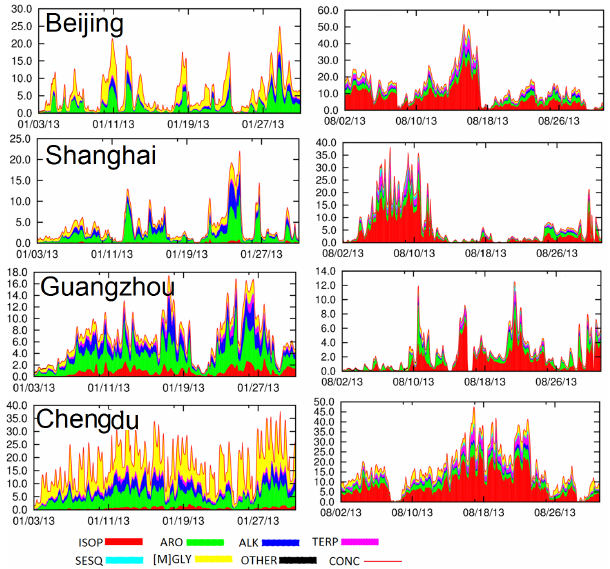
Figure 7. Predicted time series of SOA concentrations (secondary y axis, units are µgm − 3 ) and fractional contributions to SOA due to different precursors at four cities (Beijing, Shanghai, Guangzhou and Chengdu) in January and August 2013. Units are µgm − 3 . ARO: aromatics; ISOP: isoprene; TERP: monoterpene; SESQ: sesquiter- pene; [M]GLY: glyoxal + methylglyoxal directly emitted or from other precursors; OTHER: boundary conditions.